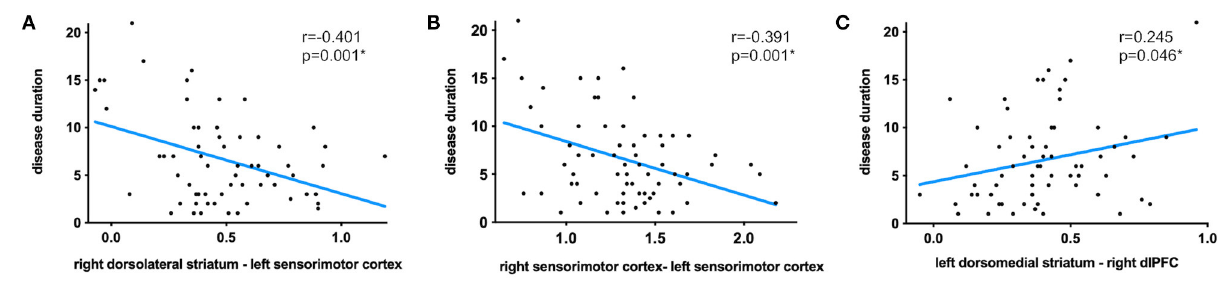
FIGURE 3 | Significant correlations between disease duration and functional connectivity strength between the right dorsolateral striatum–left sensorimotor cortex pair (A) , bilateral sensorimotor cortex pair (B) , and left dorsomedial striatum-right dlPFC pair (C) .